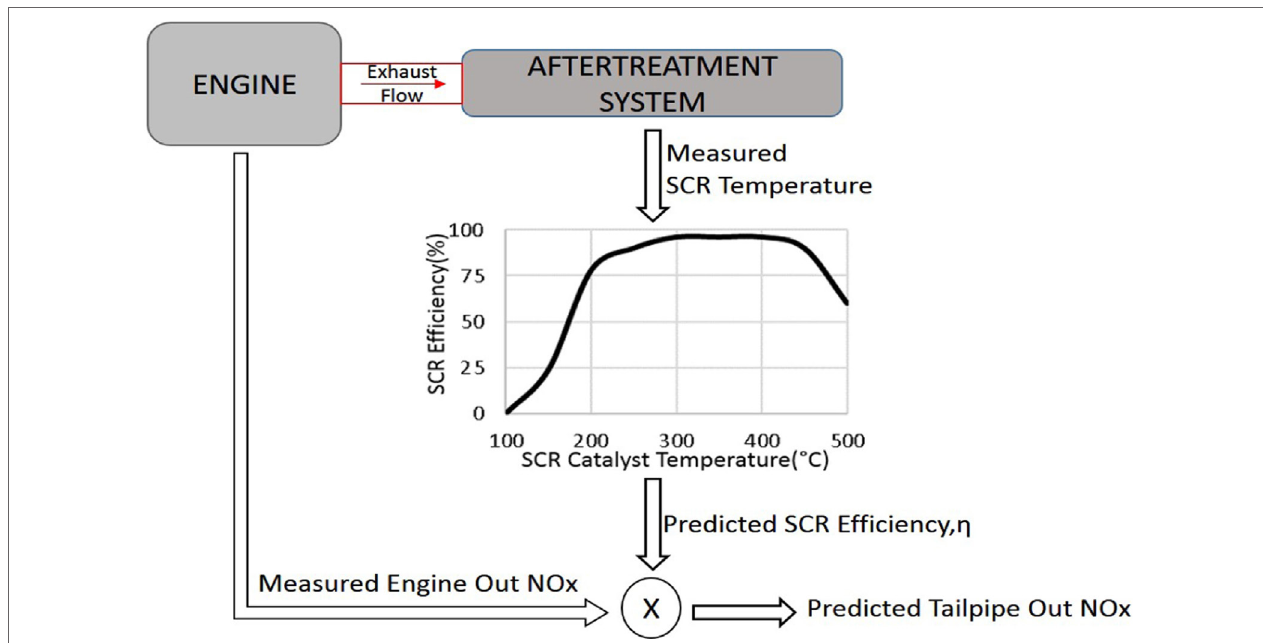
FigUre 15 | Measured SCR temperature from the A/T hardware is used to predict SCR efficiency. The SCR efficiency curve shows that efficiency reaches its maximum value for catalyst temperatures between 250 and 450°C. Tailpipe-out NOx is estimated using this predicted SCR